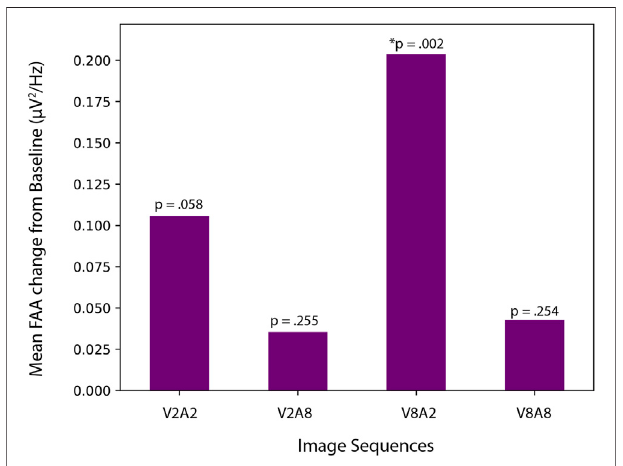
FIGURE 7 | Increase in FAA from baseline for each of the four image